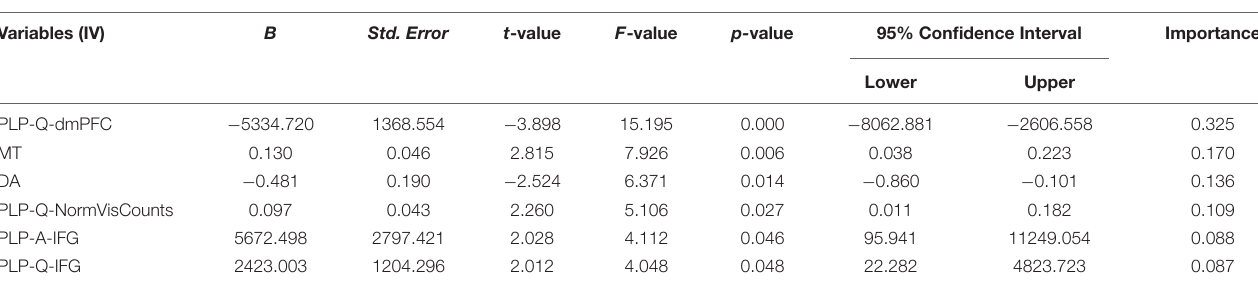
TABLE 5 | Automatic linear modeling results for the PLP